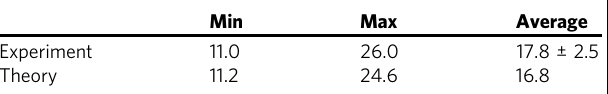
Table 2 Experimental and computed Young ’ s moduli in the x − z plane Min Max